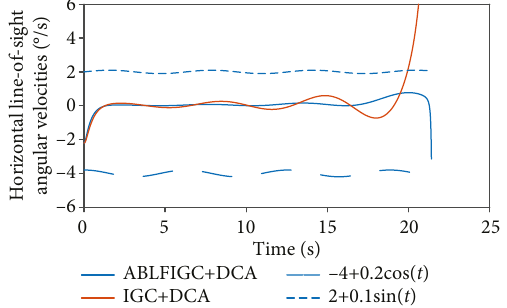
Figure 21: Curves of angular velocities of horizontal line of sight of the interceptor missile in Scenario 2: ABLFIGC+DCA refers to a combination of the proposed asymmetric barrier Lyapunov function-based IGC algorithm and the dynamic control allocation algorithm; IGC+DCA refers to a combination of the IGC algorithm subject to the traditional dynamic surface sliding-mode control law and the dynamic control allocation algorithm.